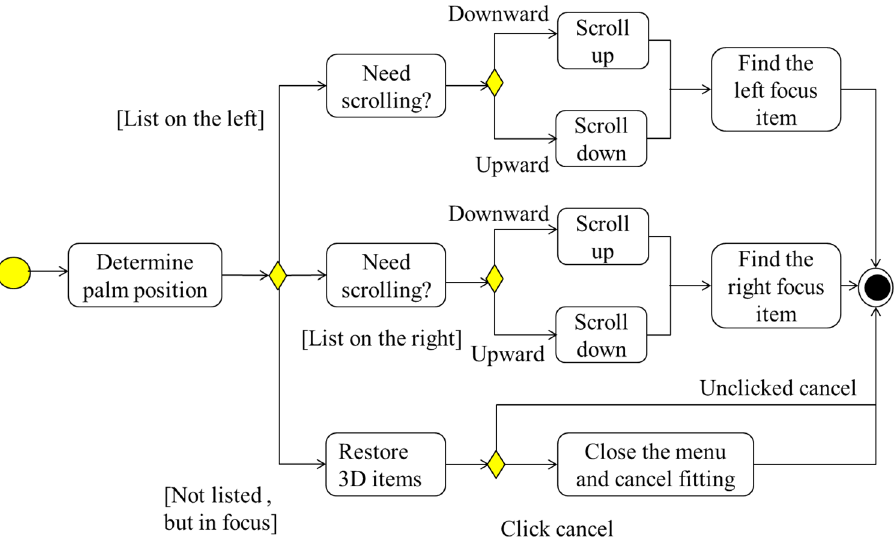
Figure 8. Activity diagram of interactive response module.